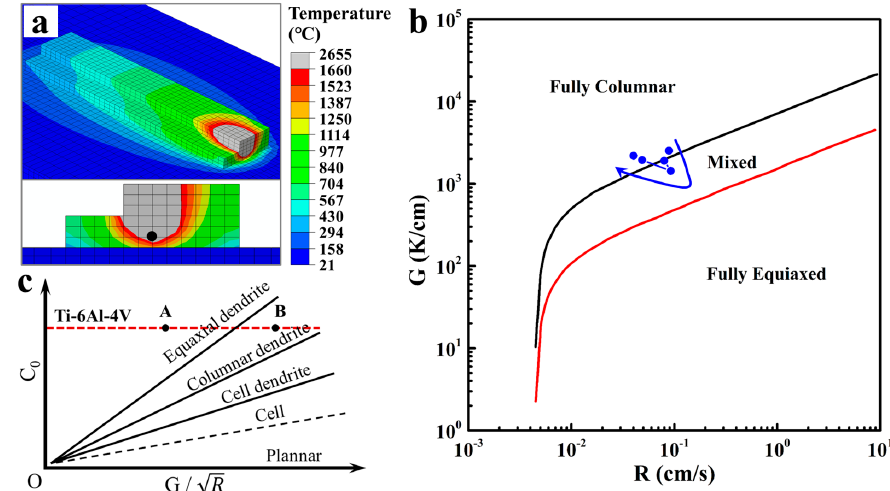
Figure 7. ( a ) Temperature field of deposition blocks; ( b ) Ti-6Al-4V solidification map with simulated data points; ( c ) Effect of G/ R on the grain morphology of solid solution at a specific C 0 for Ti-6Al-4V. Table 3. Thermal gradient and solidification velocity of the point at the onset of solidification.